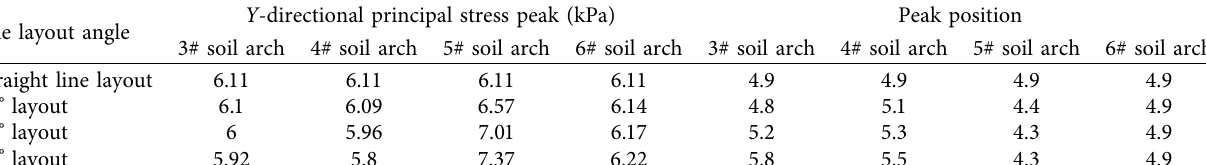
Table 2: Peak statistics for the Y-directional principal stresses of soil arches.